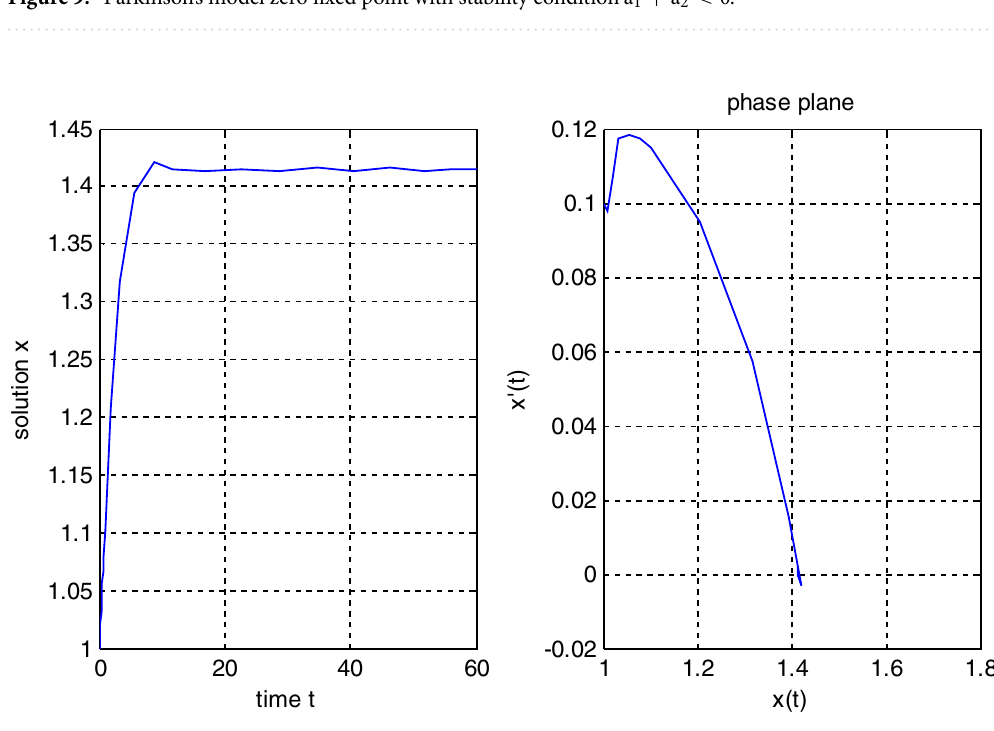
Figure 9. Parkinson’s model zero fixed point with stability condition a 1